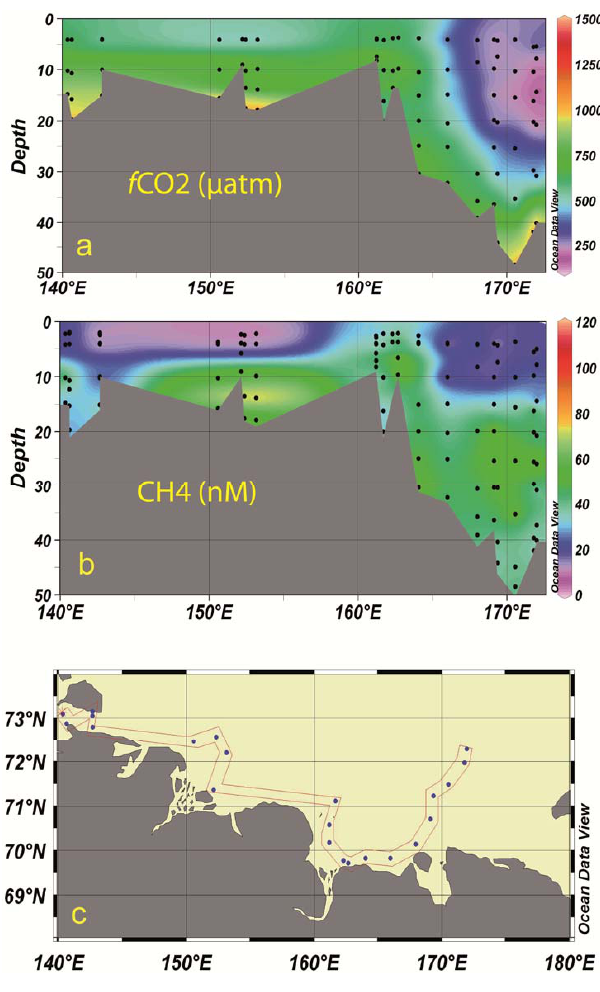
Fig. 10. Distribution of f CO 2 (a) and dissolved CH 4 (b) at the “alongshore” transect (c) in the summer 2008. 569 570